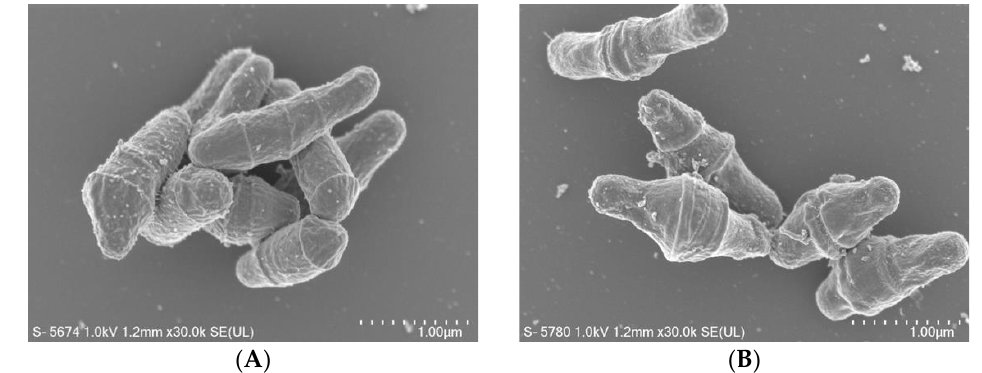
Figure 2. SEM images of culturable ( A ) and VBNC ( B ) C. diphtheriae ATCC700971.